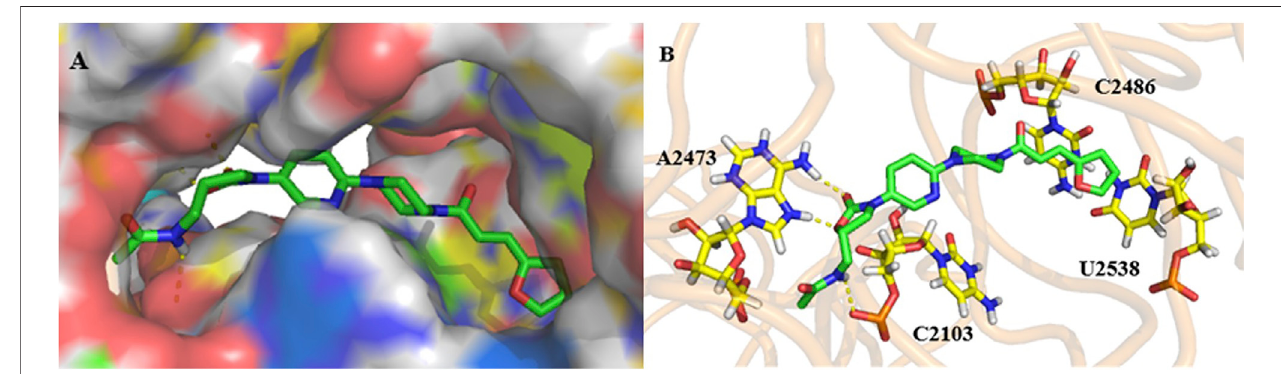
FIGURE5| Dockingstudy:compound 17g (green)dockedwithribosomalpeptidyltransferasecenter(PTC)of50Sribosomalsubunitfrom Haloarculamarismortui (PDB ID: 3CPW). (A) compound 17g in an active pocket; (B) compound 17g docking with a nucleotide residue.